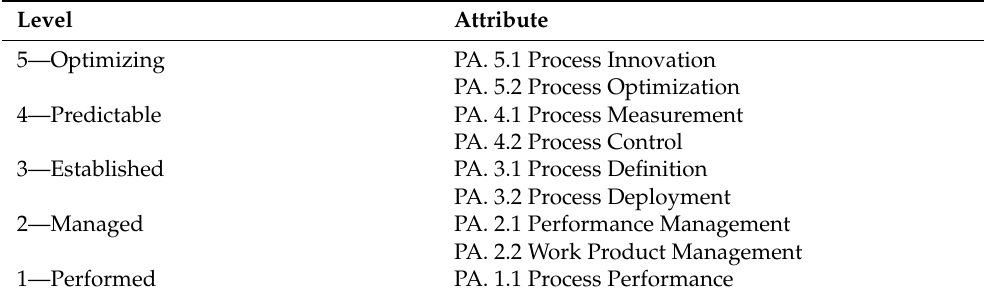
Table 3. Maturity Levels in ISO/IEC